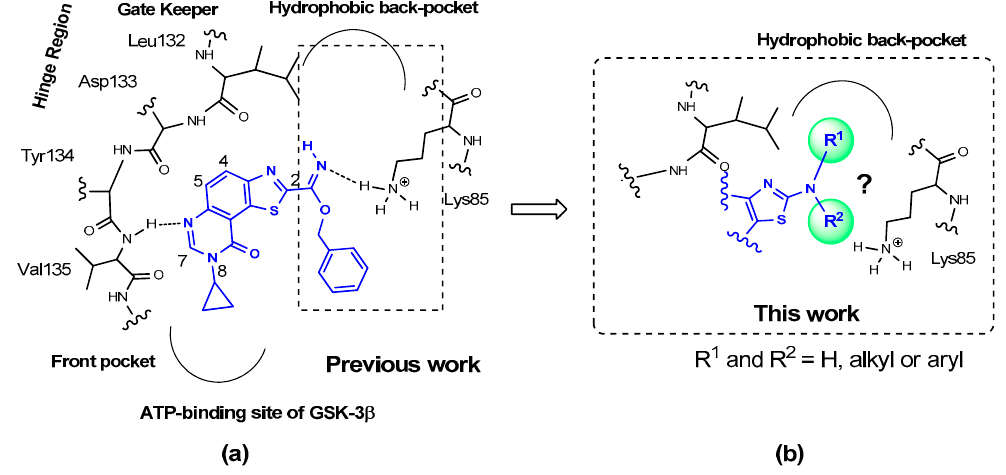
Figure 2. ( a ) Schematic representation of binding mode of one of the lead compounds in the ATP-binding site of GSK-3; ( b ) Description of the aminoalkyl and aryl substituents envisioned in position 2 of the thiazole with the aim of a better affinity and selectivity for target kinases (e.g., GSK-3).